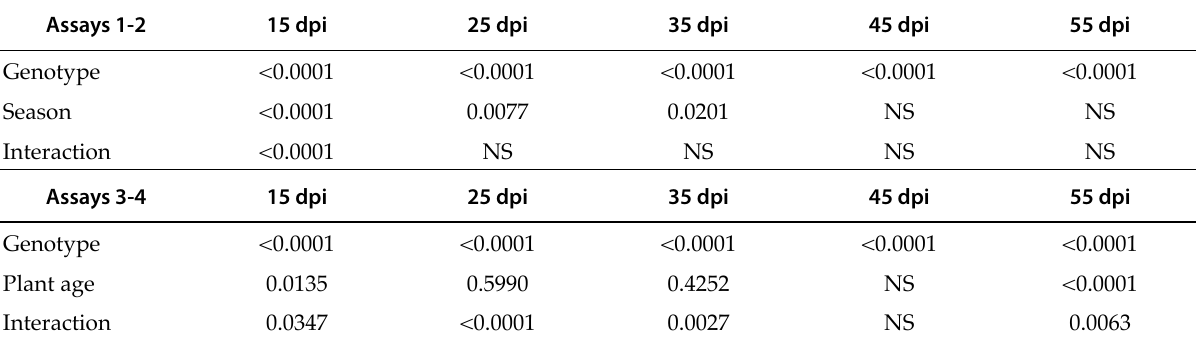
Table 2. P-values from ANOVA tests of the effects of experimental factors and their interactions, on symptom scores at the different evaluation dates, in assays 1-2 and